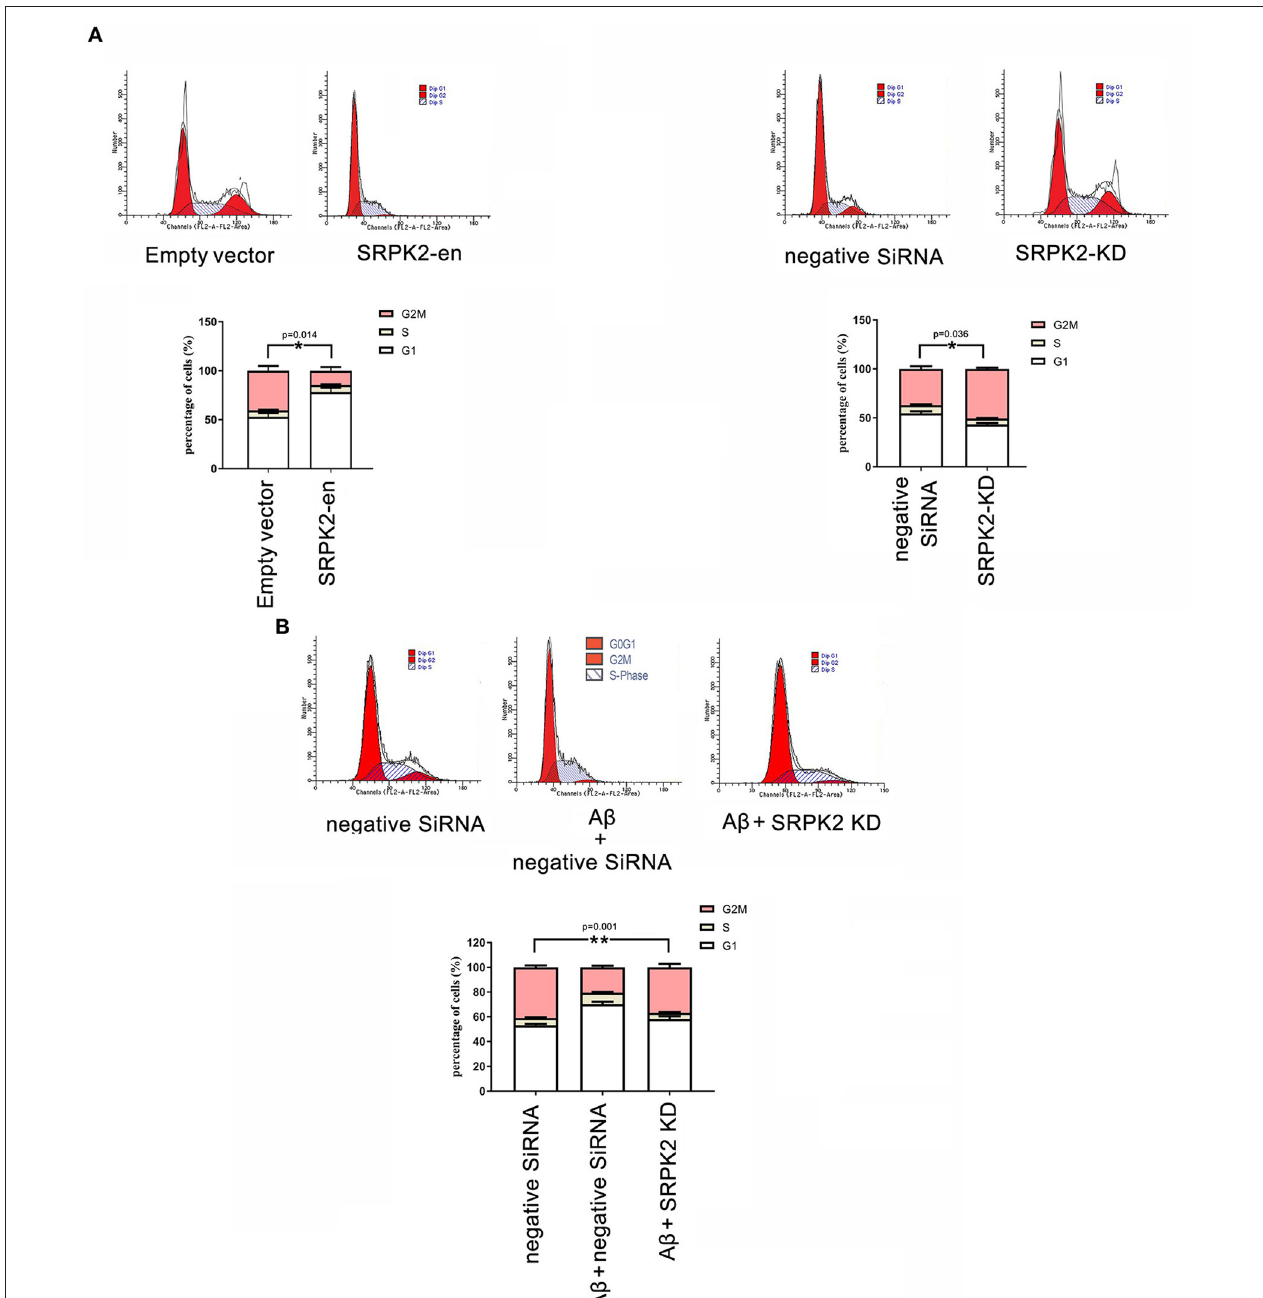
FIGURE 4 | The effect of SRPK2 expression on the BV2 cell cycles. (A) The BV2 cells with different treatments (transfection of SRPK2 recombinant lentiviral vectors or knockdown of SRPK2 by transfection of siRNA) were cultured in vitro for 72h. The cells were collected, stained with PI, and analyzed by FACS. The number of cells was indicated as the percentage of different cell cycles. The results showed that the cells with expression of SRPK2 had a higher percentage of G1/S phase compared to the controls (empty vector transfection), whereas the knockdown SRPK2 had a lower percentage of G1/S phase compared to cells transfected with negative siRNA. (B) A β treatment increased the percentage of the G1/S phase of the BV2 cells, which can be attenuated by the knockdown of SRPK2. The BV2 cells with SRPK2 knockdown were treated with A β as described in the Methods section for 72h and the cell cycles were measured and analyzed by FACS. All the results were representative of three independent experiments performed in triplicate. The results were expressed as the mean ± SEM for three replicate determinations (* p < 0.05, ** p < 0.01 by the Student’s t -test or one-way ANOVA). SRPK2-en, transfection increased SRPK2 expression; SRPK2-KD, knockdown of SRPK2 by siRNA.